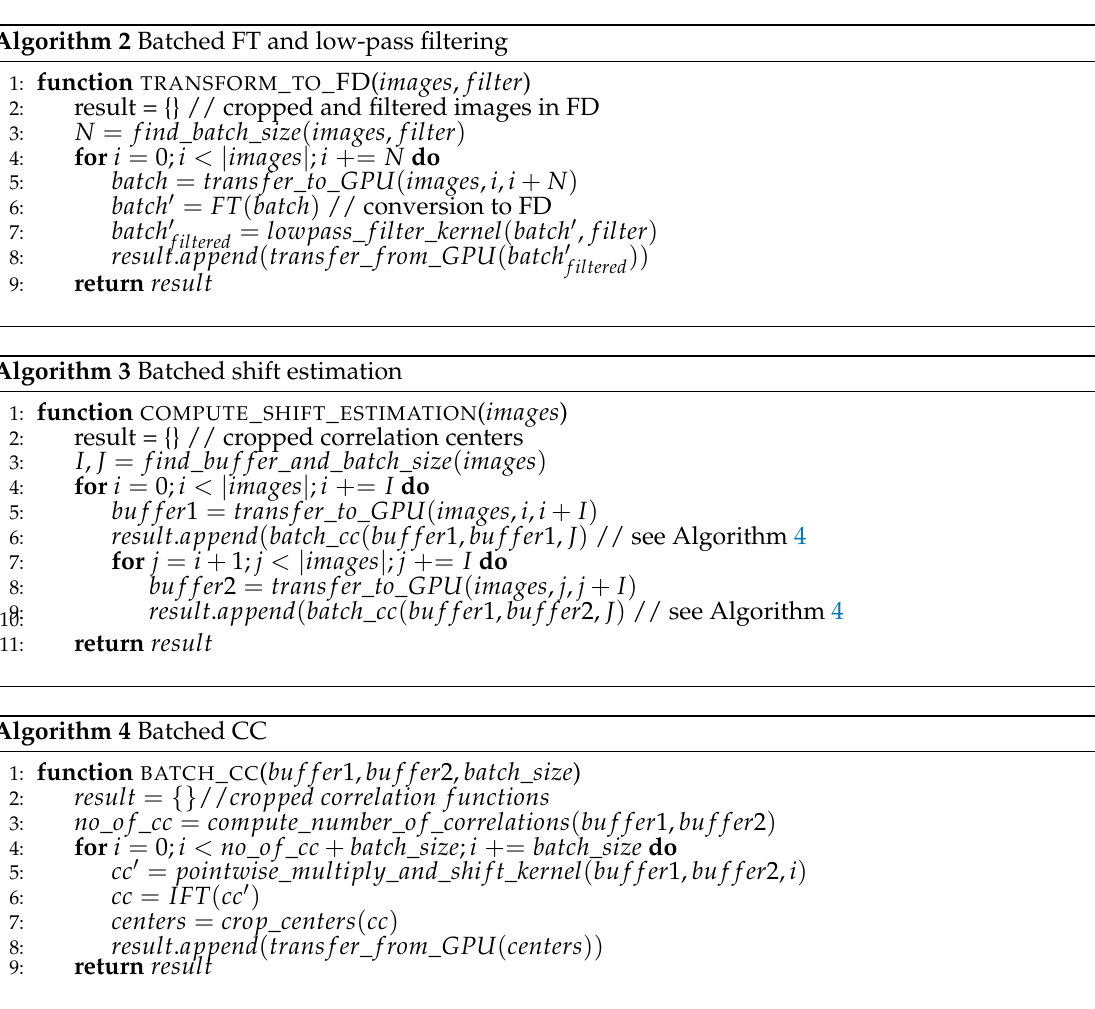
Algorithm 2 Batched FT and low-pass filtering